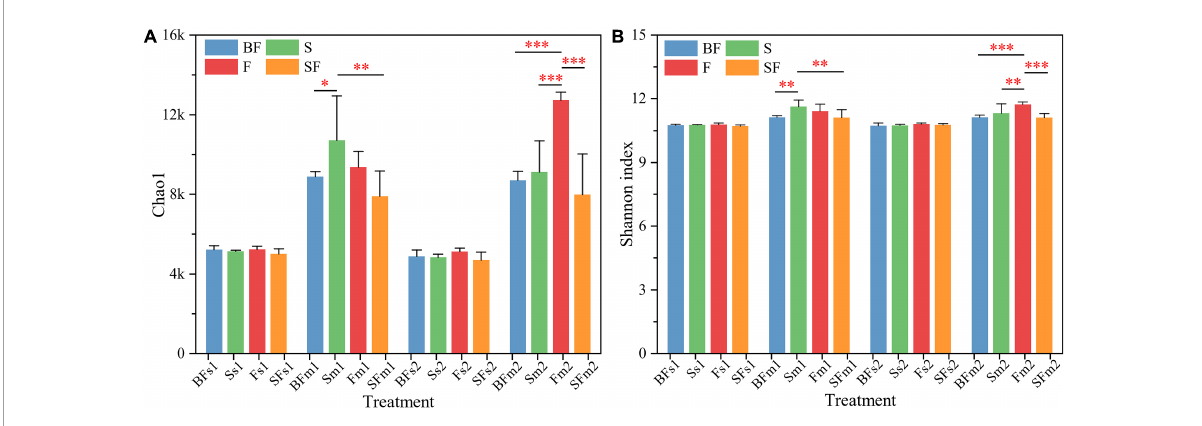
FIGURE1 Changes in 0–20 cm soil bacterial alpha diversity (Chao1 and Shannon indices) during maize growth. (A) Chao1 and (B) Shannon index. BF, S, F, and SF stand for: straw biochar with fertilizer, straw, fertilizer, and straw with fertilizer, respectively. s: Seedling stage; m: Maturity stage. 1: 0–10 cm; 2:10–20 cm. ∗ p < 0.05, ∗∗ p < 0.01, ∗∗∗ p < 0.001.